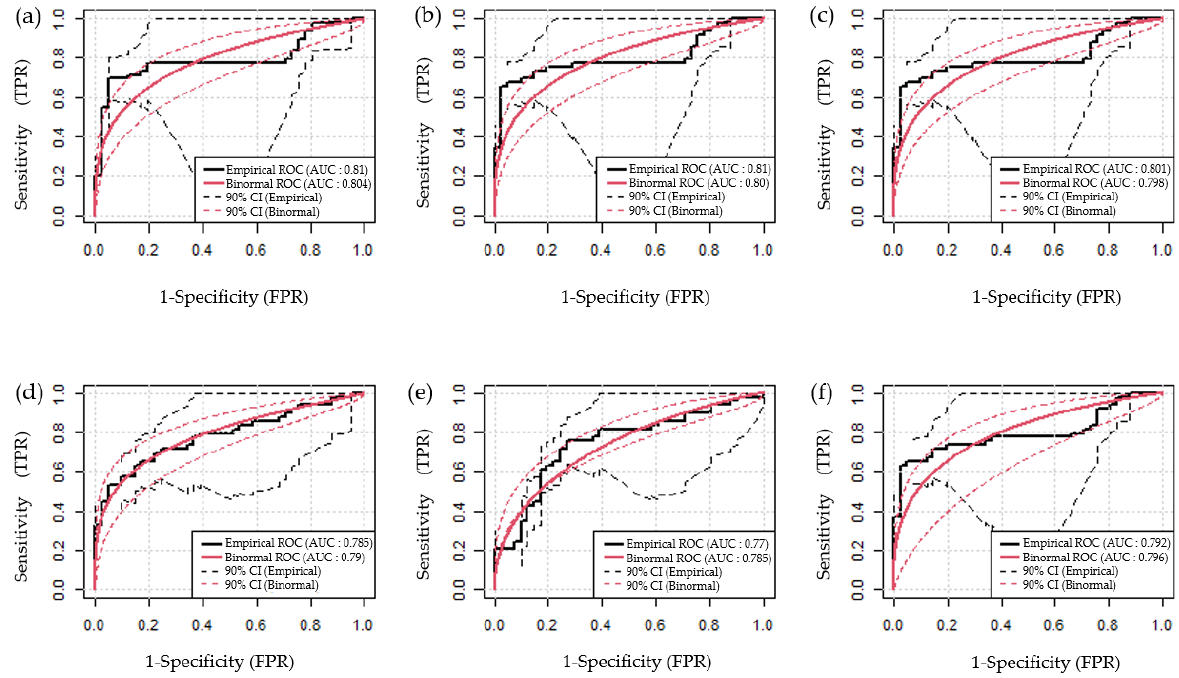
1 Figure 5. Validation of the hybrid models using empirical and binormal ROC curves, ( a ) AND, ( b ) OR, ( c ) GAMMA0.75, ( d ) GAMMA0.8, ( e ) GAMMA0.85, and ( f )